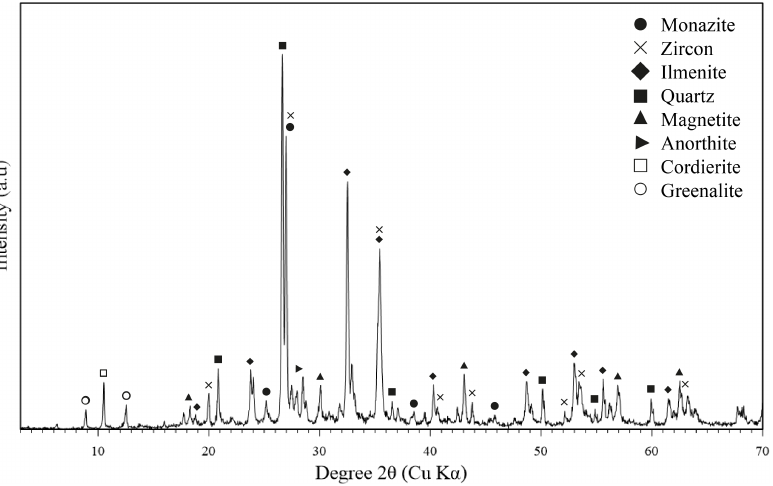
Figure 7. XRD diffractogram of the alluvial gold mining residue. Table 1. Chemical composition by ICP-OES of the alluvial gold mining